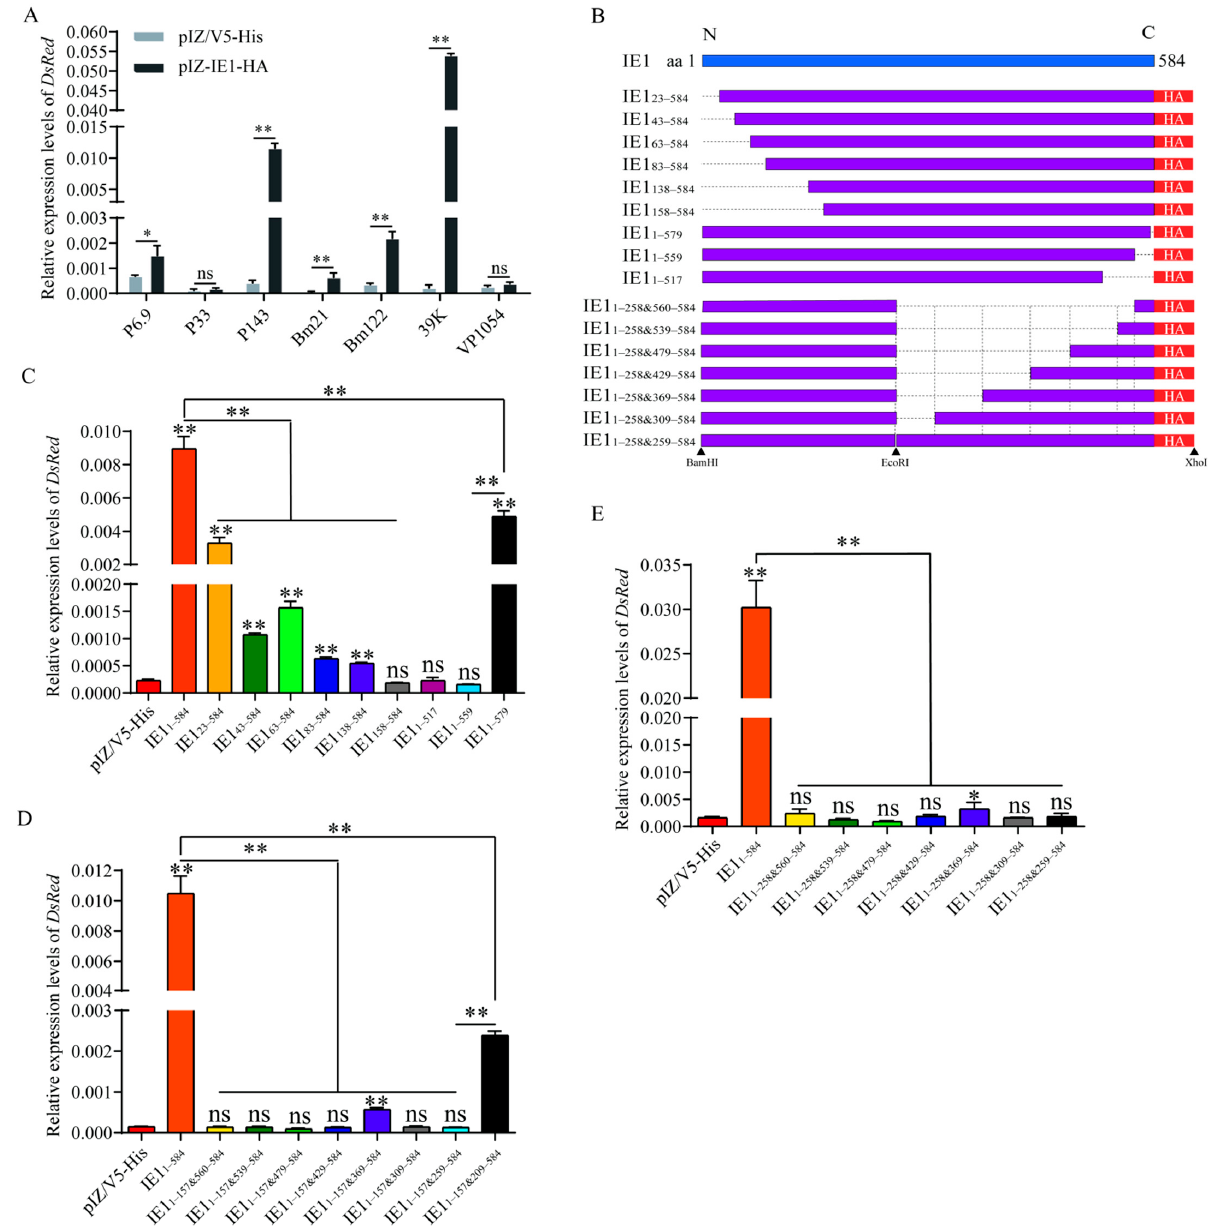
Figure 4. Identification of key functional domains for the transactivation of BmNPV IE1. ( A ) Tran- scriptional activation of different viral promoters by IE1. pIZ-IE1 1-584 was co-transfected with pGL3-P6.9-DsRed, pGL3-P33-DsRed, pGL3-P143-DsRed, pGL3-Bm21-DsRed, pGL3-Bm122-DsRed, pGL3-39K-DsRed, or pGL3-vp1054-DsRed into BmN-SWU1 cells. At 48 h p.t., the transcriptional